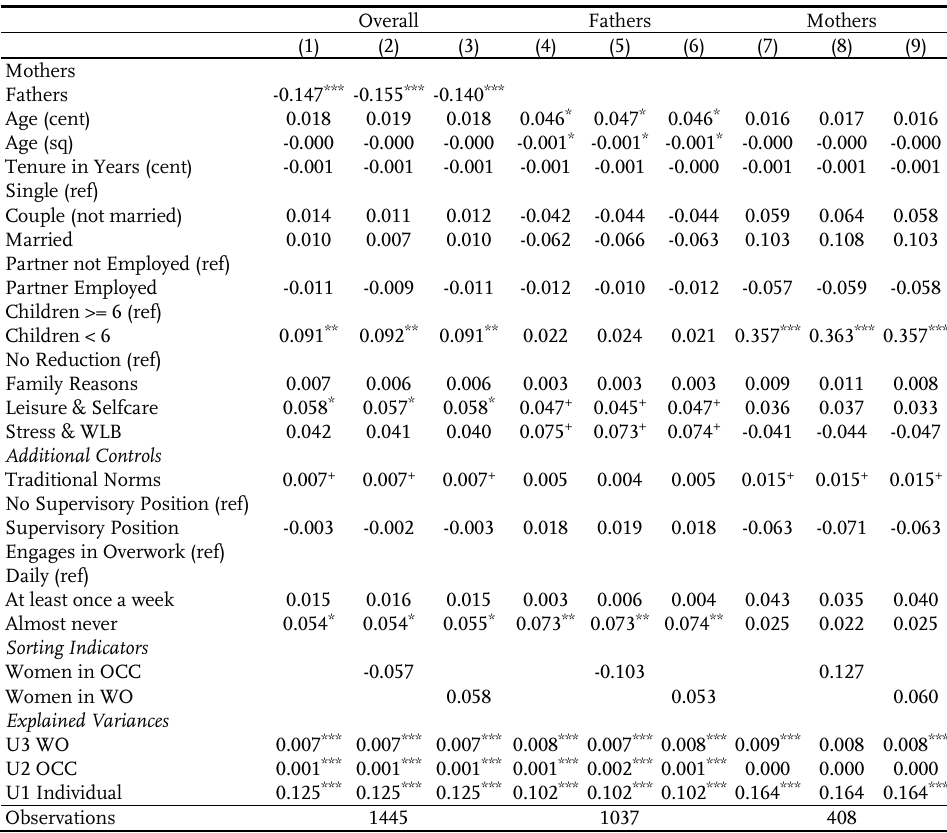
Table A.2 : Cross classified multilevel model on reduction of contracted working hours (additional control